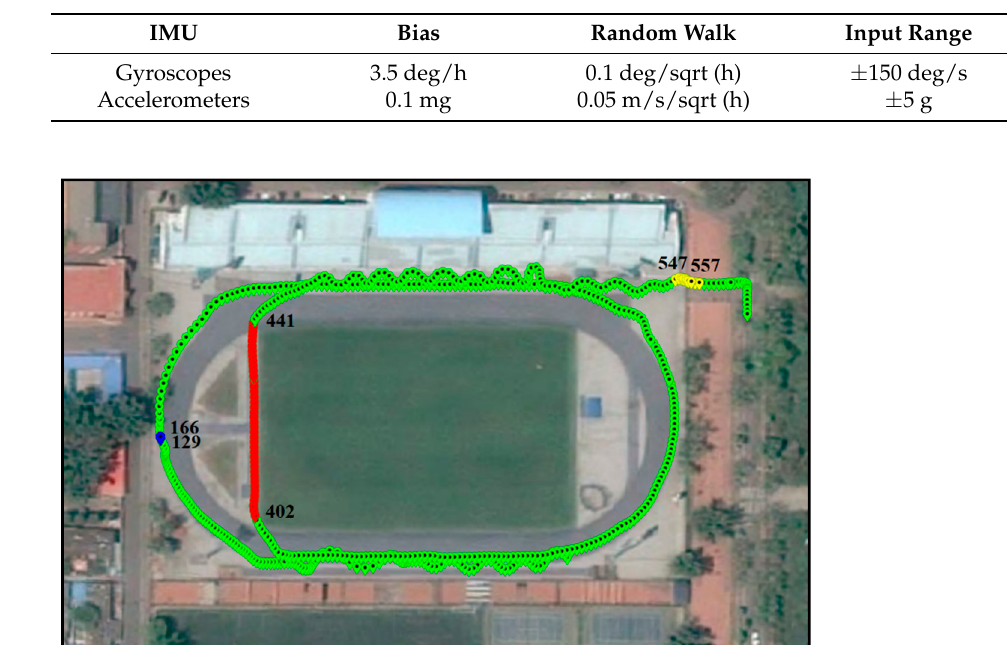
Figure 2. Trolley trajectory collected in a sports field in Beijing. The background image is obtained from LocaSpace Viewer. The blue track points indicate that the trolley is at rest (during epoch 129–166); the red track points indicate that the trolley is moving in a straight line in an approximate north direction (during epoch 402–441); the yellow track points indicate that the trolley is passing on uneven roads (during epoch 547–557).